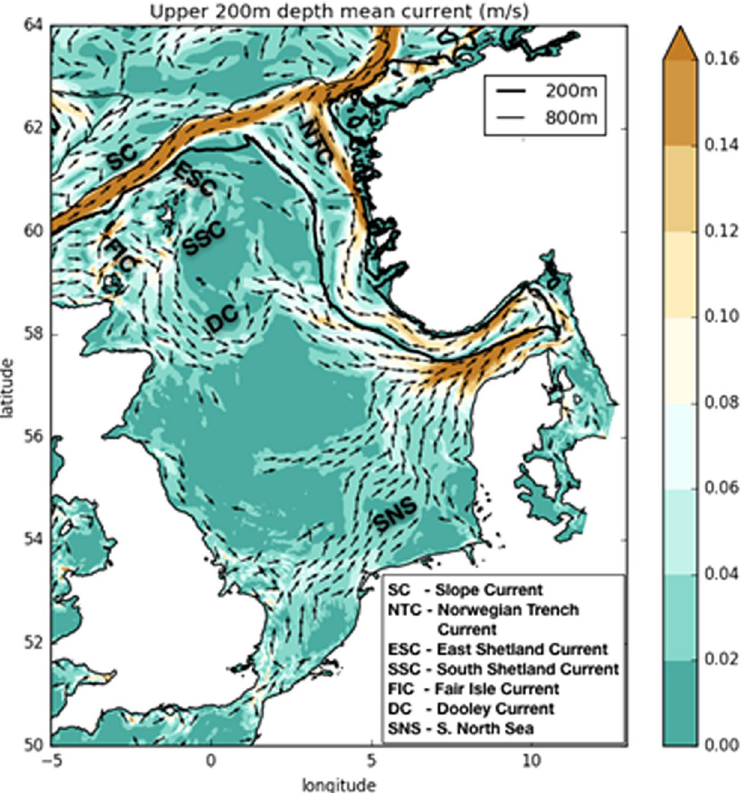
Figure 1. North Sea circulation computed from 2010–2012 time- and depth-average upper 200 m velocity field. Computed from AMM60 (Guihou, 2017). The 200 m and 800 m isobaths are contoured in